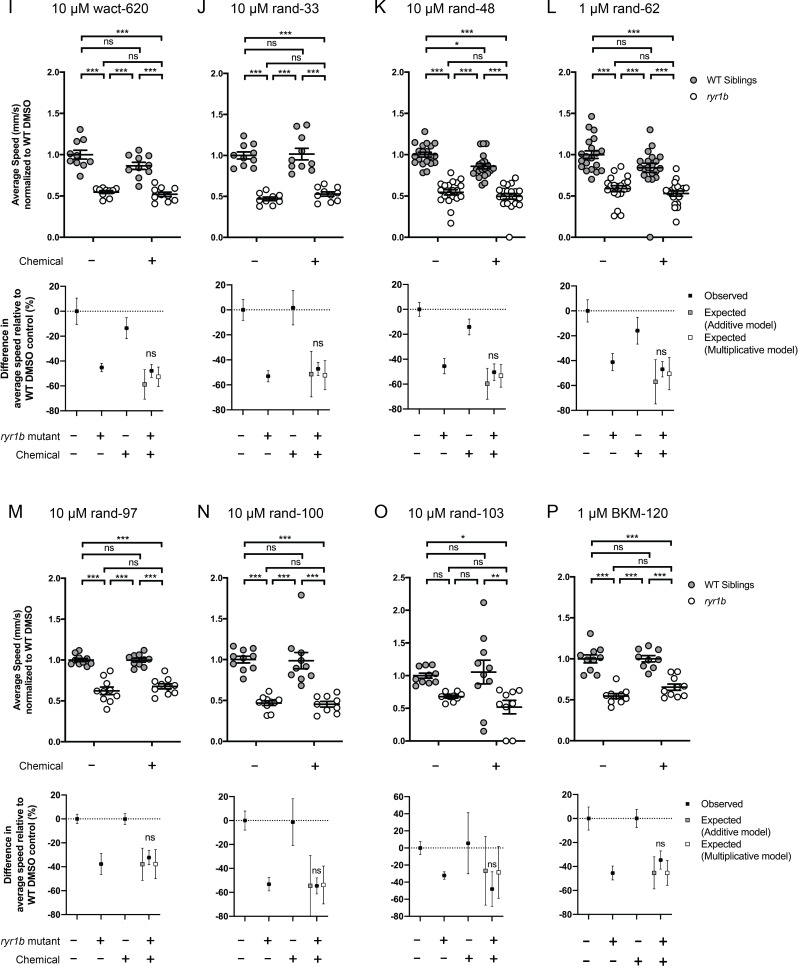
Chemical-genetic interactions were tested using zebrafish larval movement speed as a readout.Compared to the average speed of DMSO WT controls, chemical-genetic interactions were not observed for 18 hits from the C. elegans screen when tested in this assay (Figure 4—figure supplement 2–3F–W). Data are presented as mean ± SEM movement speed (mm/s) normalized to DMSO-treated WT siblings for n = 2 independent experiments for (A–E), (G), (H), (K), (L), and (R), where sample size n = 19 or 20 for each treatment group in a set and n = 1 experiment and sample size n = 9 or 10 for the remainder. Statistical analysis by two-way ANOVA followed by Tukey’s multiple comparisons post-test. *p<0.05, **p<0.01, ***p<0.001.